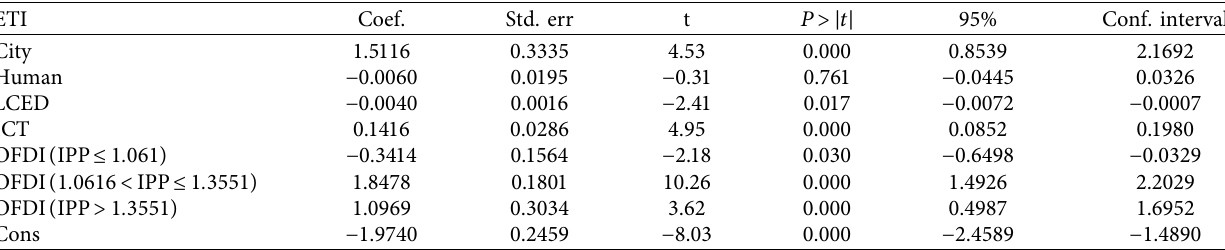
Table 7: Model parameter estimation